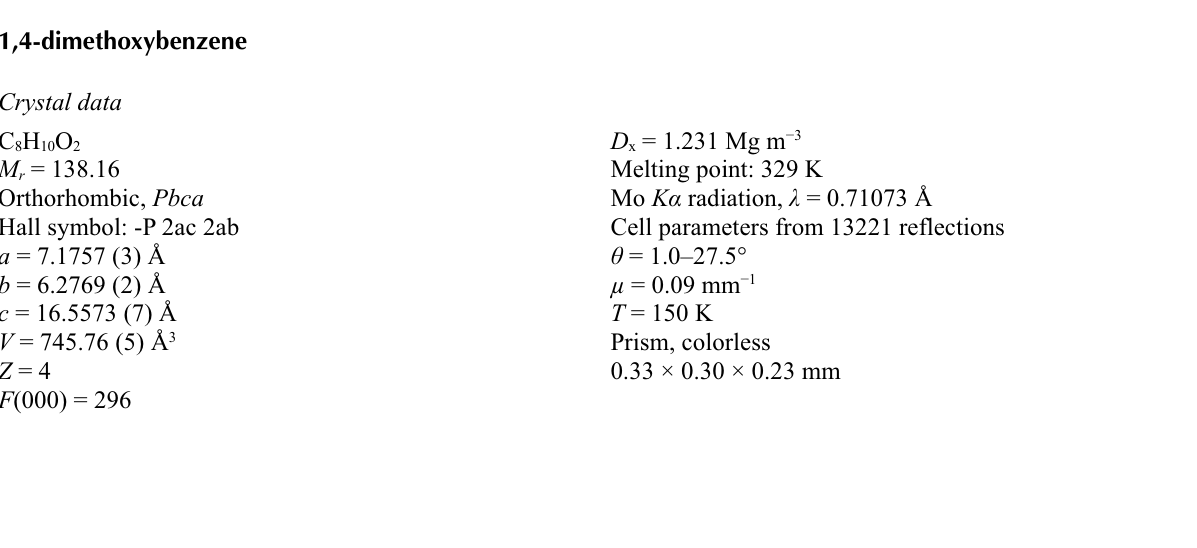
Figure 2 The redetermined structure of (I) from the present